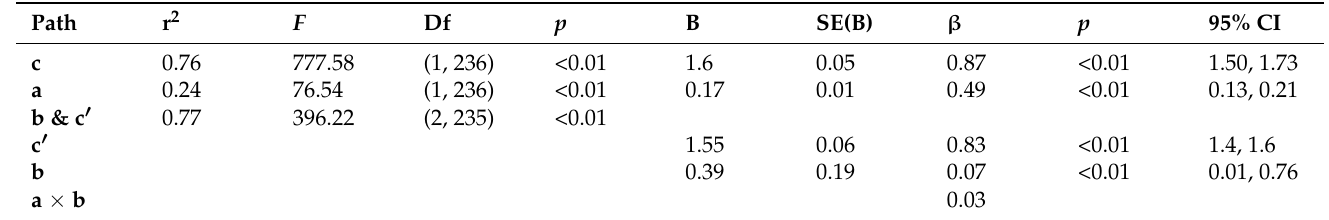
Table 5. The mediation model for the investigated variables: parental self-efficacy, relationship satisfaction, marital (couple)